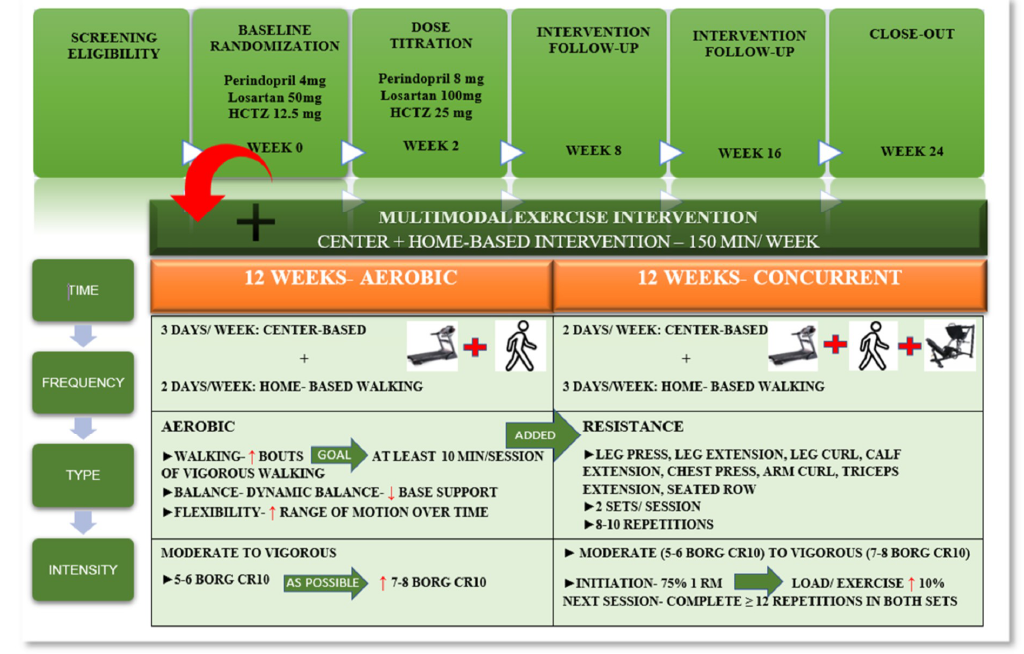
Figure 1. Intervention design characteristics. In the aerobic phase, exercise sessions began with a brief